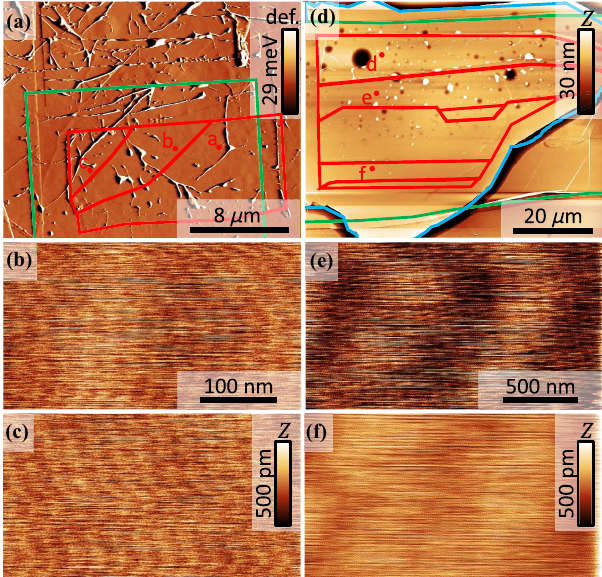
FIG. 7. Topography maps of the studied terraced graphene samples. (a) Topography map of the sample measured in Figs. 2(a) – 2(c), as reflected by the deflection error channel in contact mode. The layer markings are as in Fig. 6(a). (b),(c) Topography maps in contact mode taken simultaneously with Figs. 2(a) and 2(b), respectively [(b),(c) share a color scheme and a scale bar]. (d) Topography map of the sample measured in Figs. 2(d) – 2(f), as reflected by tapping mode scan. The layer markings are as in Fig. 6(b). (e),(f) Topography maps in contact mode taken simultaneously with Figs. 2(d) and 2(e), respectively [(e),(f) share a color scheme and a scale bar]. The locations of the scans of Figs. 2(a) – 2(f) are marked over (a) and